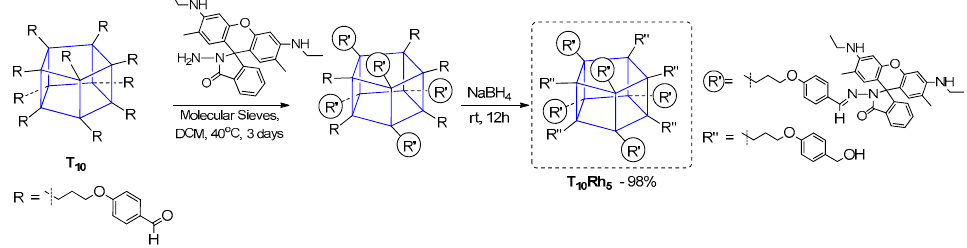
Figure 4. Synthetic path to obtain rhodamine B hydrazidedecorated T 10 via an imidation